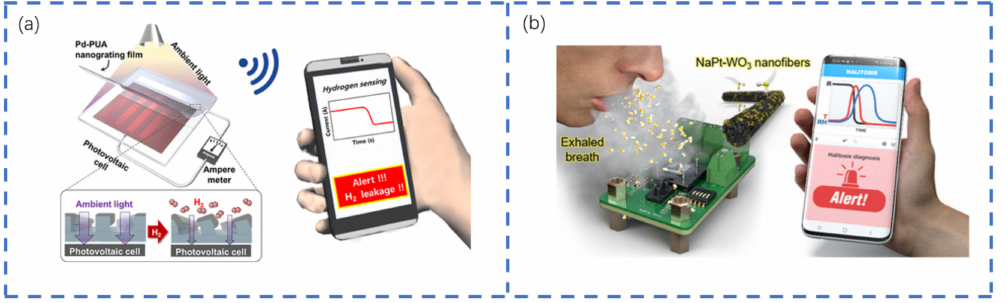
Figure 9. Application of a flexible sensor based on a chemical formula: ( a ) schematic diagram of a self-powered H 2 gas sensor [103]; ( b ) surface-active tuned metal oxide chemical resistor for direct analysis of human mouth odor